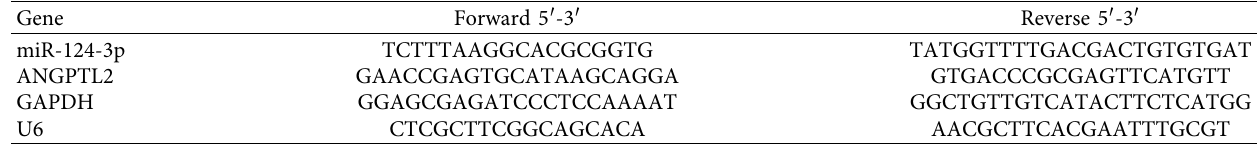
Table 1: Primer sequences.